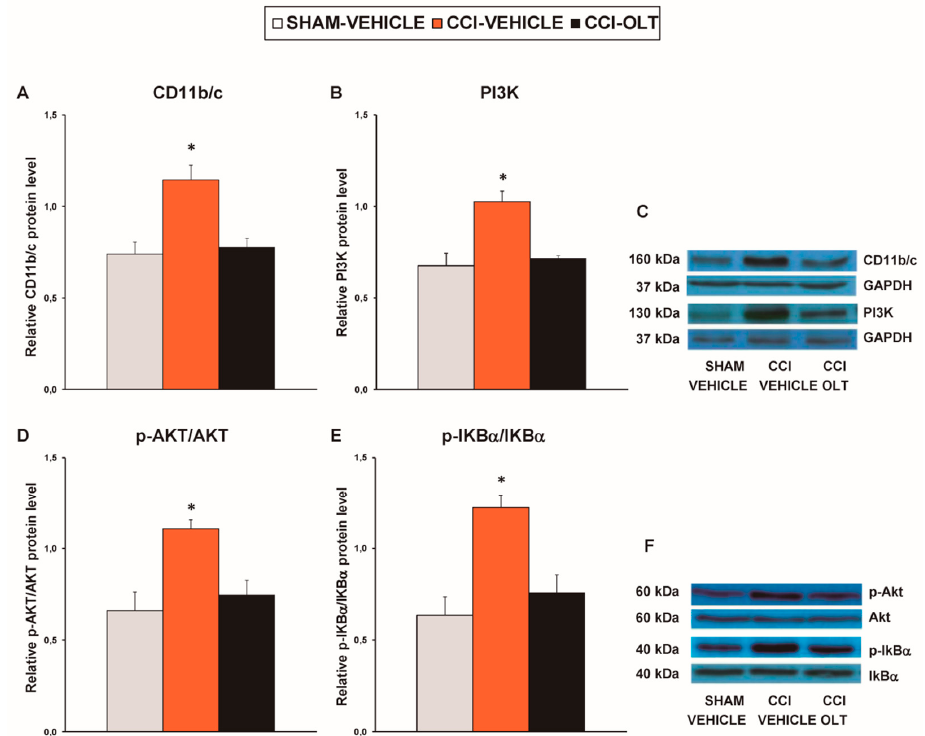
Figure 3. E ff ects of oltipraz on the expression of CD11b / c, phosphoinositide 3-kinase (PI3K), phosphorylated protein kinase B (p-Akt), and phosphorylated inhibitor of κ B α (p-IkB α ) in the spinal cord of the CCI-injured mice. The relative protein levels of ( A ) CD11b / c, ( B ) PI3K, ( D ) p-Akt, and ( E ) p-IKB α on the ipsilateral side of the spinal cord in the CCI-injured mice treated with oltipraz (OLT) or vehicle are represented. The sham-operated mice (SHAM) treated with vehicle were used as controls. ( C ) Representative examples of blots for CD11b / c (160 kDa), PI3K (130 kDa), and GAPDH (37 kDa), and ( F ) for p-Akt (60 kDa), Akt (60 kDa), p-IKB α (40 kDa) and IKB α (40 kDa). CD11b / c and PI3K are expressed relative to GAPDH levels whereas phosphorylated proteins are expressed relative to their corresponding total proteins. In all panels, * denotes significant di ff erences vs. sham-operated mice treated with vehicle ( p < 0.05; one-way ANOVA followed by the SNK test). Results are presented as the mean ± SEM; n = 5 samples per experimental